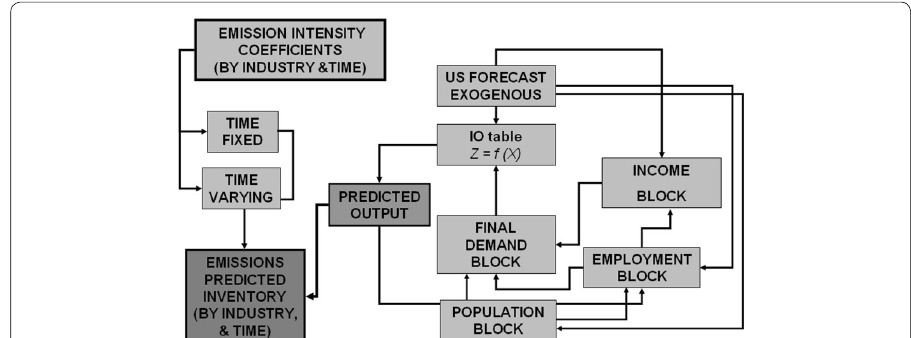
Fig. 6 Overview of the integrated econometric–emission modeling system